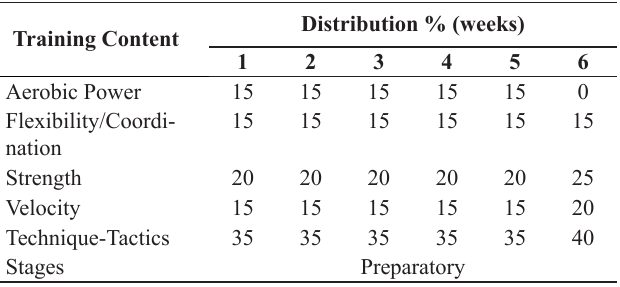
Table 2. Distribution of the training content among different capaci - ties and skills during the preparatory stage.